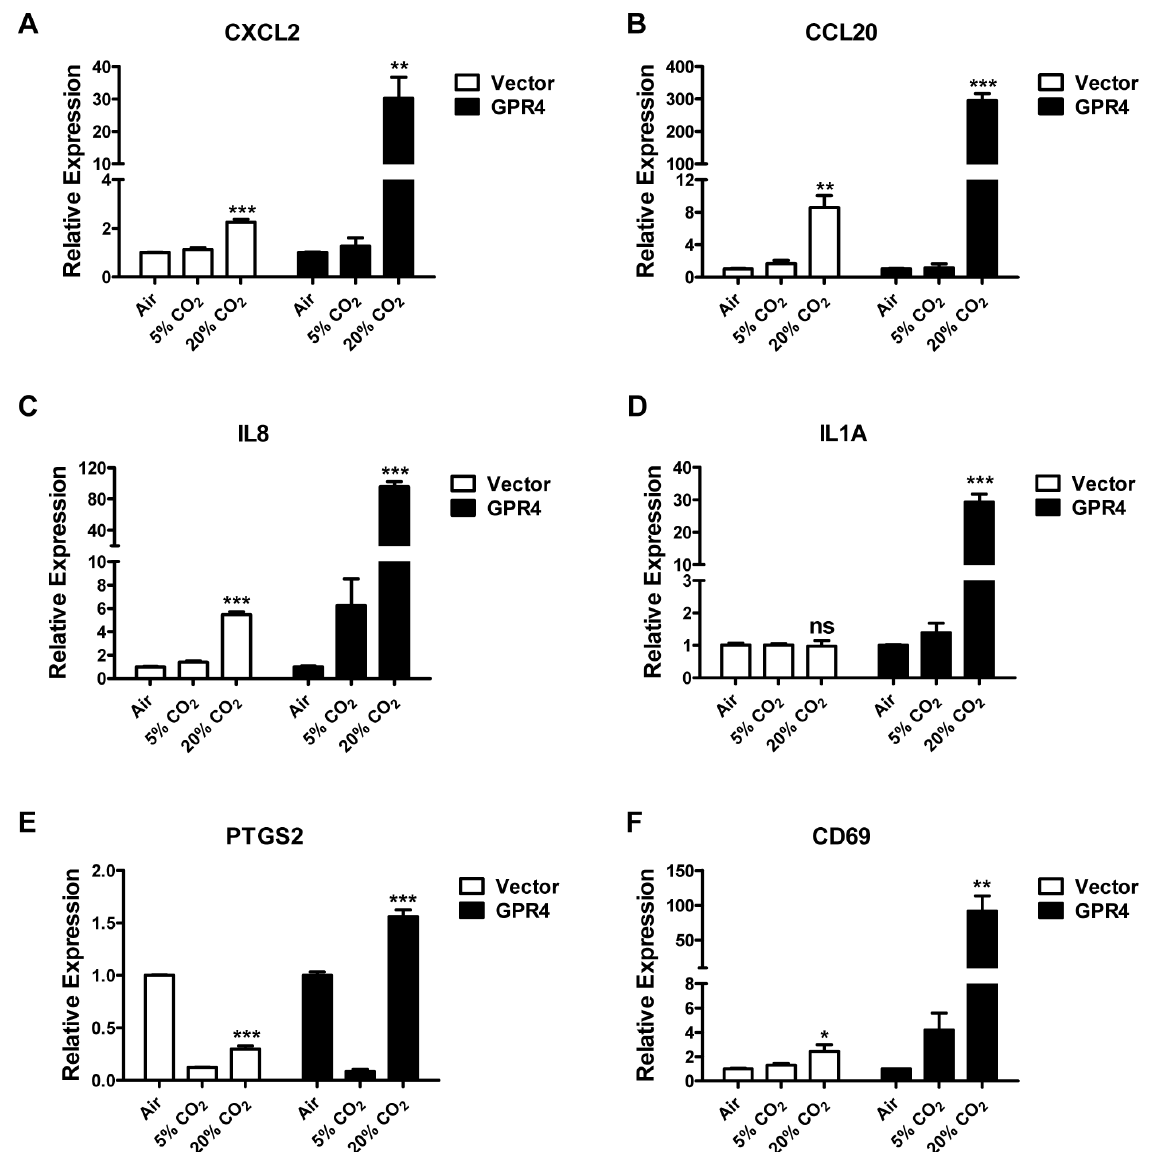
Figure 4. Hypercapnic acidosis activation of GPR4 increases the expression of inflammatory genes in HUVEC. HUVECs transduced with the control vector (Vector, white bars), or GPR4 expression construct (GPR4, dark bars) were treated for 5 h with EGM-2 media buffered with ambient air, 5% CO 2 or 20% CO 2 . Real-time RT-PCR quantification of mRNA levels of CXCL2 (A), CCL20 (B), IL8 (C), IL1A (D), PTGS2 (E), and CD69 (F) was performed. Ct values were normalized to the housekeeping gene GAPDH. The expression level of the target genes in HUVEC/Vector or HUVEC/GPR4 cells treated with ambient air-buffered EGM-2 medium was set as 1. Error bars indicate the mean 6 SEM. *, P , 0.05; **, P , 0.01; ***, P , 0.001; ns , not significant ( P . 0.05); compared with the ‘ambient air’ groups. The results shown are the average of two biological